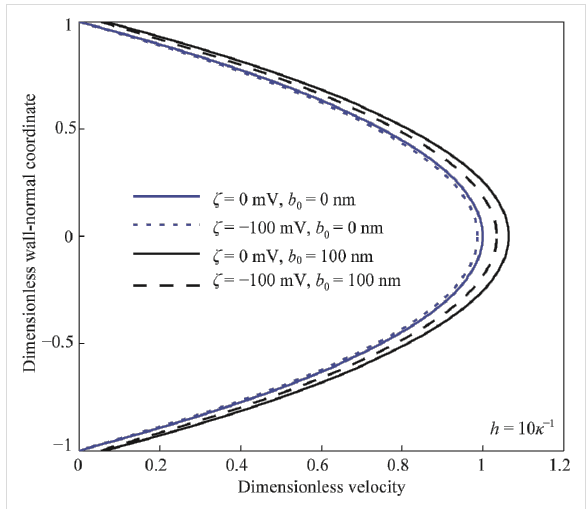
Figure 5: The dimensionless velocity field in the microchannel with different conditions of surface charge and boundary conditions.